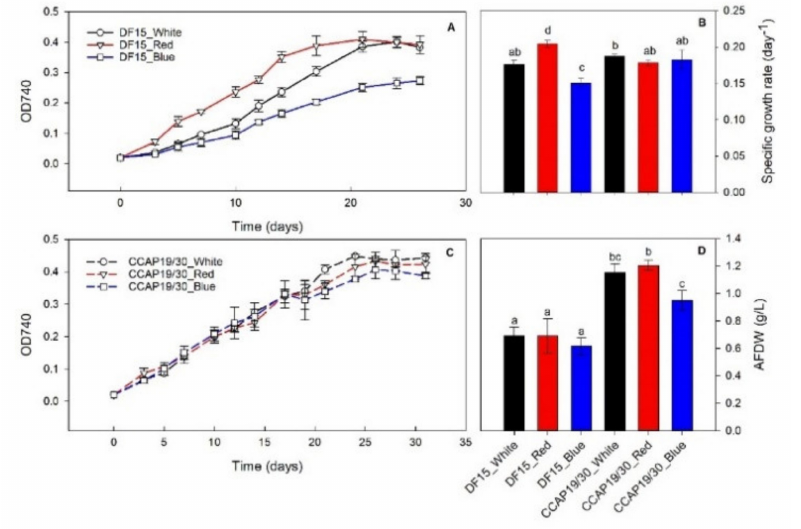
Figure 1. Growth curve at OD740 of D. salina DF15 ( A ), D. salina CCAP19/30 ( C ), their maximum specific growth rate and ( B ) and final biomass concentration ( D ). Cultivation was conducted at 25 ◦ C, pH 7.5 and 100 rpm mixing using white, red and blue light at 200 µ mol photons m − 2 s − 1 . Data are expressed as the means ± standard deviation. The different letters indicate statistically different groups (significance level at p -value <